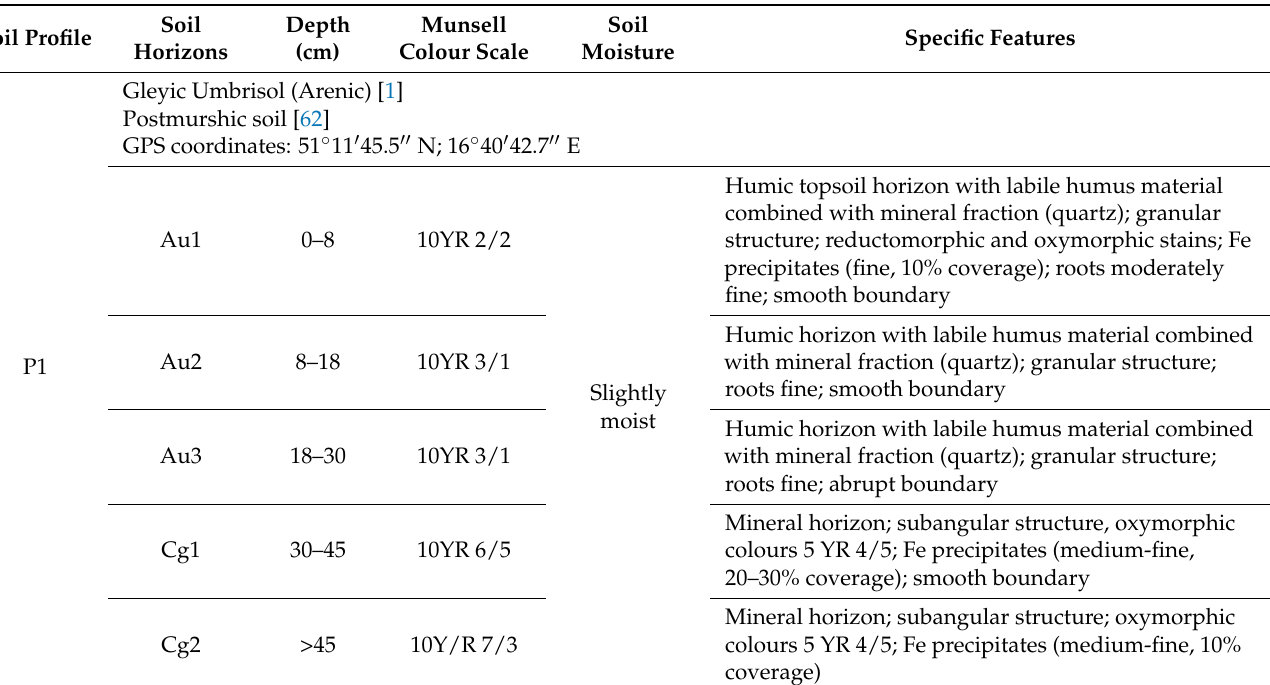
Figure 2. Morphology of soils under study: ( A ) Gleyic Umbrisol (Arenic) (postmurshic soil) (P1); ( B ) Calcic Drainic Sapric Murshic Histosols (Limnic) (sapric murshic soil) (P2); ( C ) Calcic Sapric Histosols (Limnic) (sapric peat soil) (P3). Table 1. Basic morphological information of